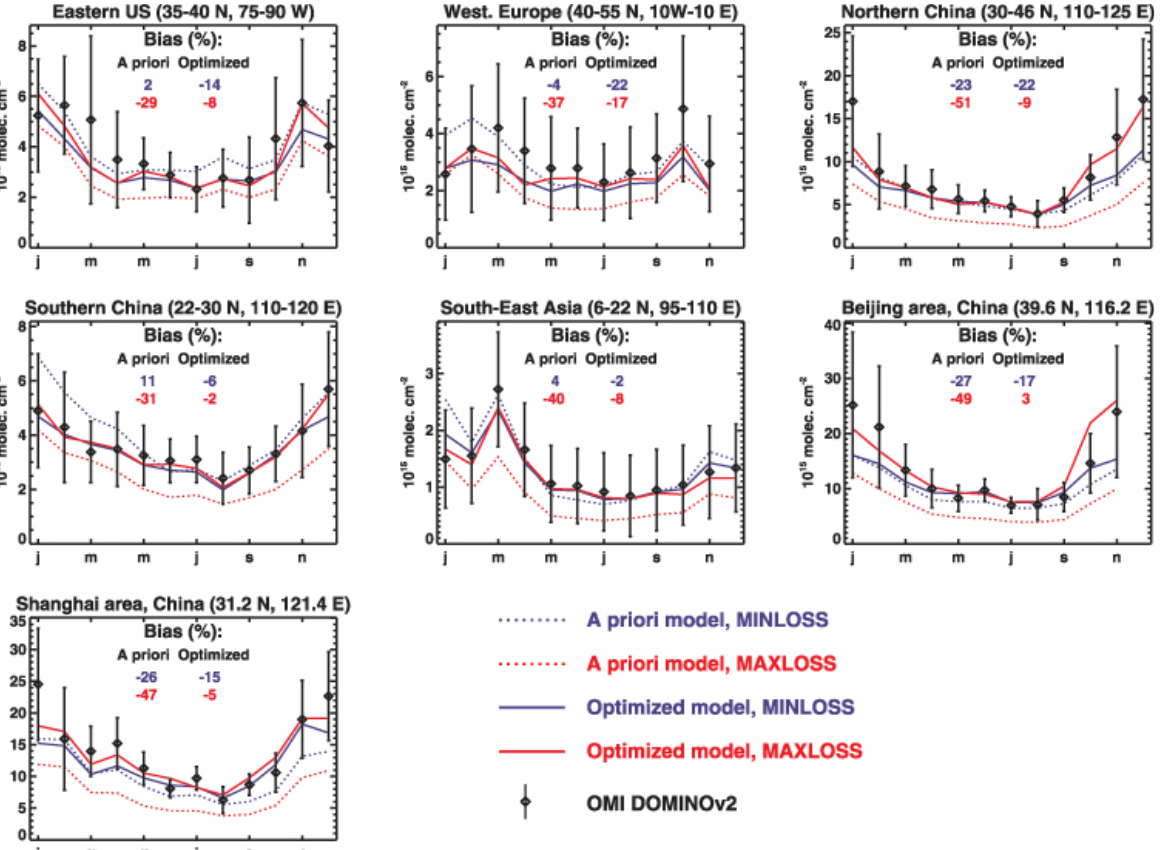
Fig. 9. Seasonal variation of NO 2 columns over large regions. Comparisons between OMI retrievals (diamonds), a priori (dotted), and optimized (solid) columns in MINLOSS (blue) and MAXLOSS (red) for 2007. Percentage biases are given inset. The NO 2 column errors are as described in Sect.